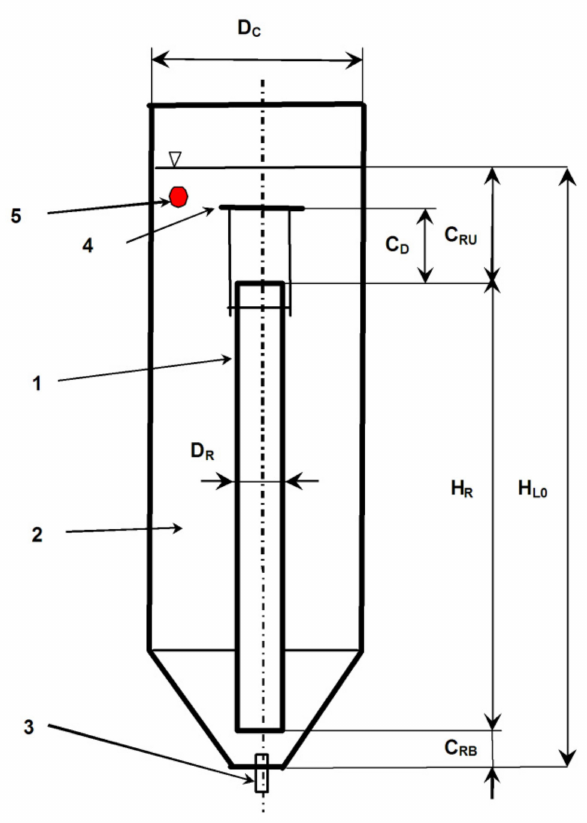
Figure 1. Scheme of the experimental apparatus: (1) Riser, (2) downcomer, (3) sparger, (4) deflector, (5) oxygen probe.